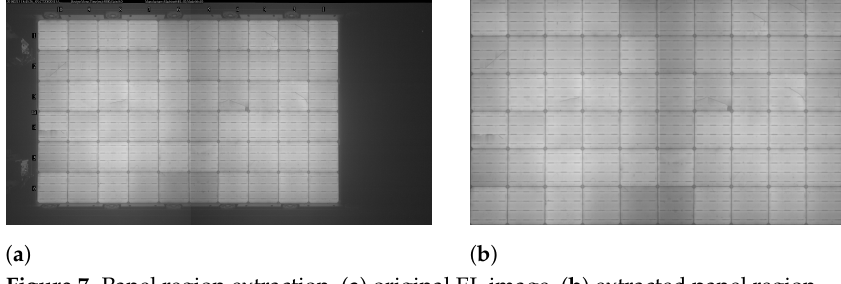
Figure 7. Panel region extraction, ( a ) original EL image, ( b ) extracted panel region. In Algorithm 2 of panel region extraction, an original EL image of resolution M × N pixels is converted to a greyscale image ( I b ). The greyscale EL image is blurred with the Gaussian smoothing to reduce unwanted noises from an EL